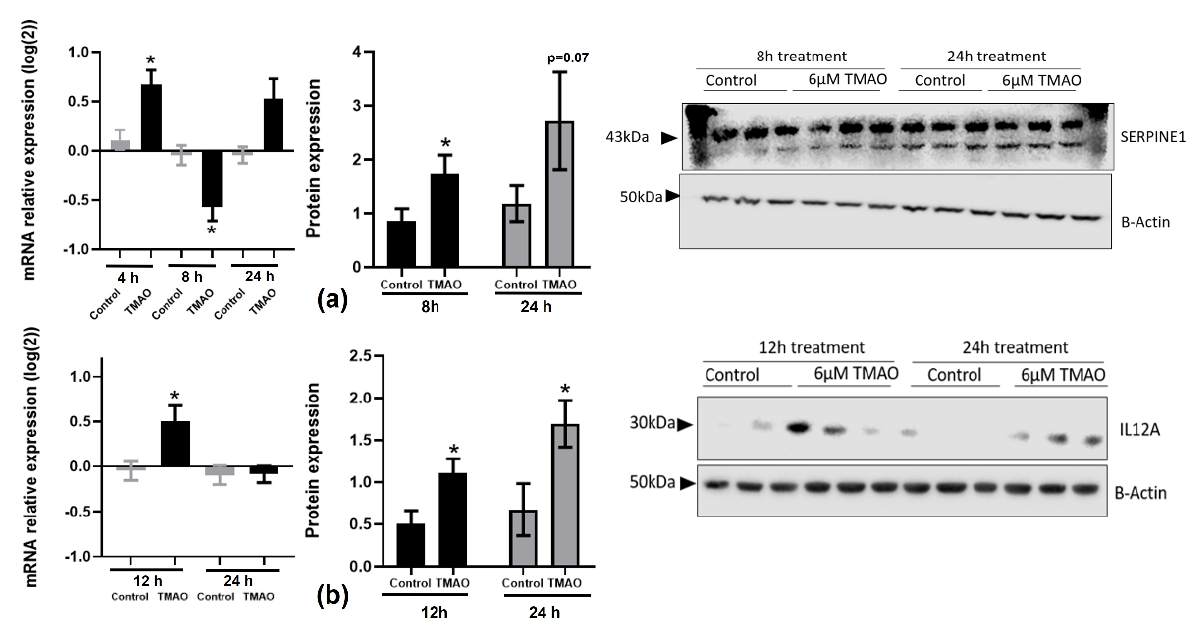
Figure 2. Effects of TMAO on SERPINE1 and IL-12A gene and protein levels: ( a ) Cells were treated with 6 µ M of TMAO for 4 h, 8 h, and 24 h to measure SERPINE1 gene expression and for 8 h and 24 h to measure SERPINE1 protein levels in HEPG-2 cells. ( b ) Levels of IL-12A were measured in THP-1 cells at 12 h and 24 h. Gene expression was measured by RT-qPCR and calculated with the 2 − ∆∆ CT method and Log 2 -transformed. Protein levels were measured by Western blotting. Band density was measured and normalized with β -actin. The mean ± SEM of three independent experiments is shown. Expression values in TMAO-incubated samples (black bars) were compared with corresponding control samples (grey bars) at each timepoint using Student’s t -test; * p < 0.05.